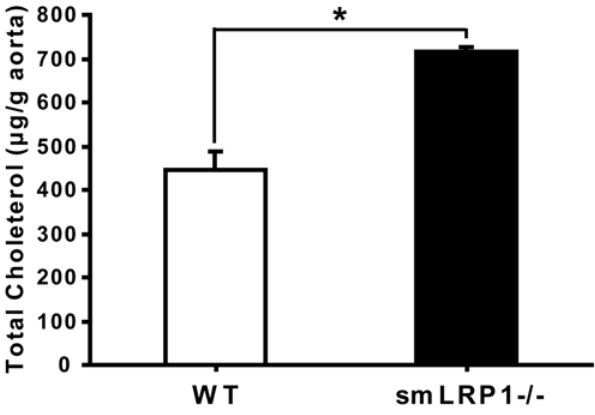
Figure 1. GC/MS analysis of cholesterol in the mouse aorta. The aorta from the aortic root to the iliac bifurcation was isolated, and the surrounding connective tissue was carefully removed under a dissecting microscope. The aorta was weighed after superficial drying with tissue paper. Cholesterol in the aorta was determined by GC/MS and the amount of total cholesterol ( m g) was normalized by the weight of the aorta (g). Significantly increased total cholesterol levels were found in the aorta of the smLRP1 2 / 2 mice (black bar). 4-month old female littermates of the indicated genotypes were used for the depicted experiment. LRP flox/flox animals lacking the Sm22Cre transgene are indistinguishable from wild type [18] and were used as control groups. Equivalent results were obtained for male mice and throughout the lifetime of the animals (Figure S1). Values were presented as mean 6 S.E.M. * p , 0.05 (compared to wild type, n=3/group).